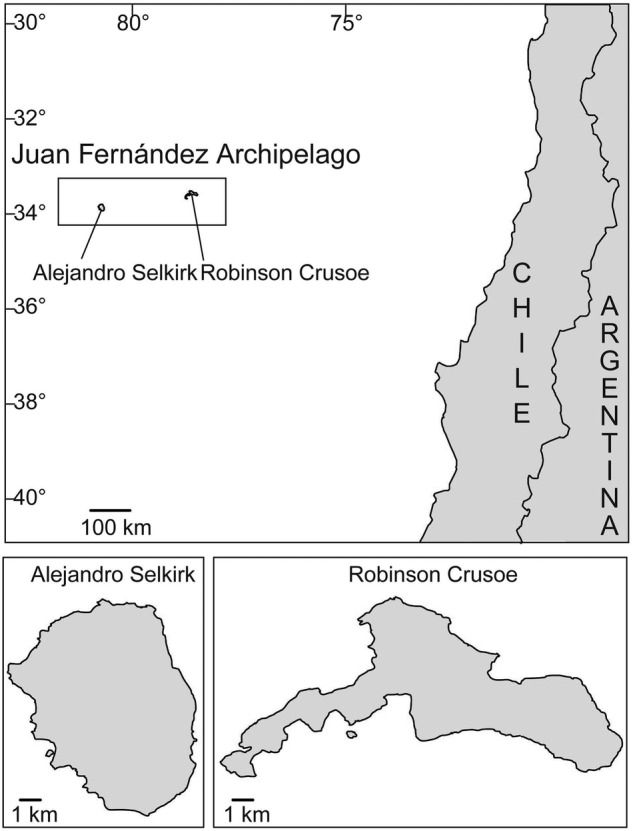
Location of the Juan Fernández Archipelago and its two major islands, Alejandro Selkirk (= Masafuera) and Robinson Crusoe (= Masatierra).